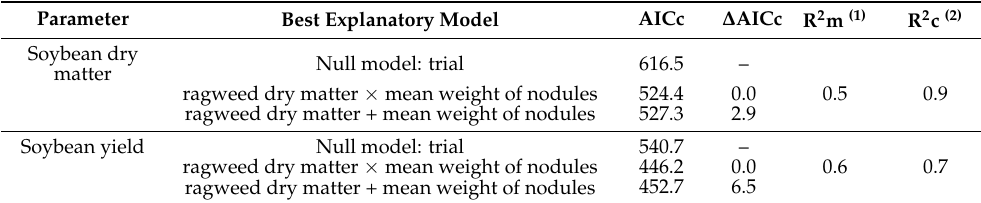
Table 3. AICc values for model selection of dependent variables; number of estimated explanatory parameters and parameter combinations = 16 based on field trial data (AICc = second order Akaike Information Criterion, ∆ AICc = difference between the AICc and that of the next most parsimonious model, R 2 m = marginal R 2 , R 2 c = conditional R 2